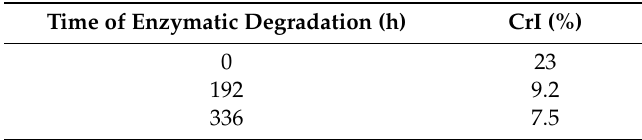
Table 3. Crystallinity index CrI of the starting cellulose nanofibers (CNFs) and after di ff erent times of enzymatic degradation with cellulose entrapped in alginate microparticles.